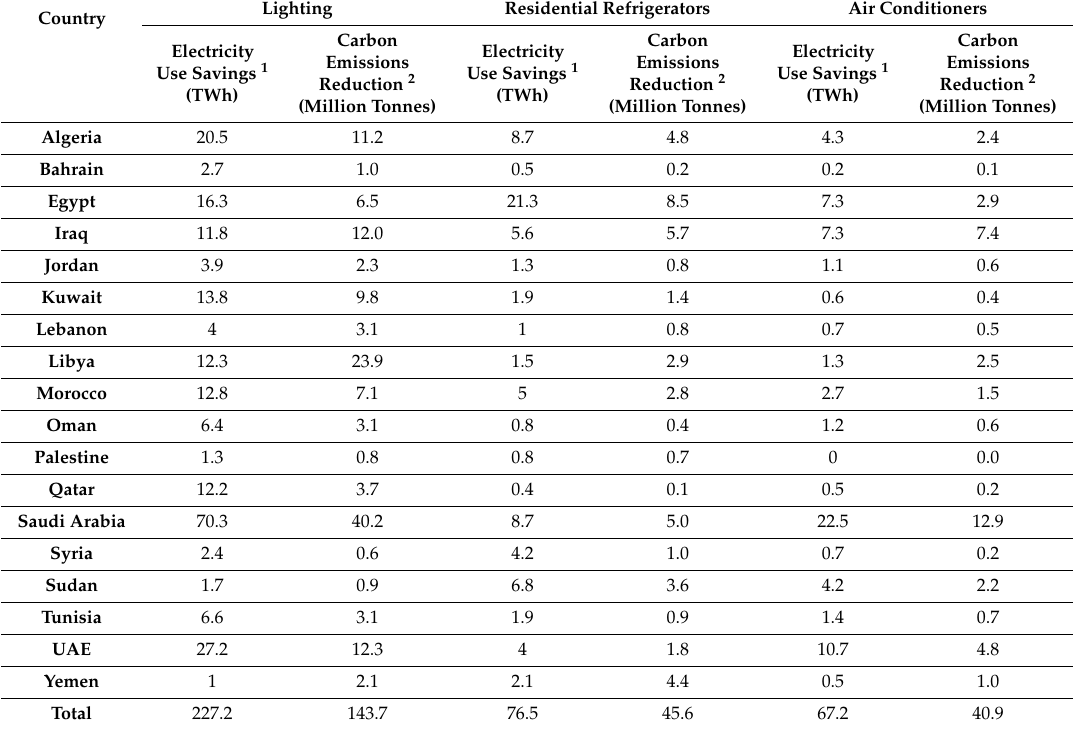
Table 16. Cumulative from 2020 to 2030 benefits attributed to improved MEPs for, lighting, residential refrigerators, and room air-conditioners in the Arab